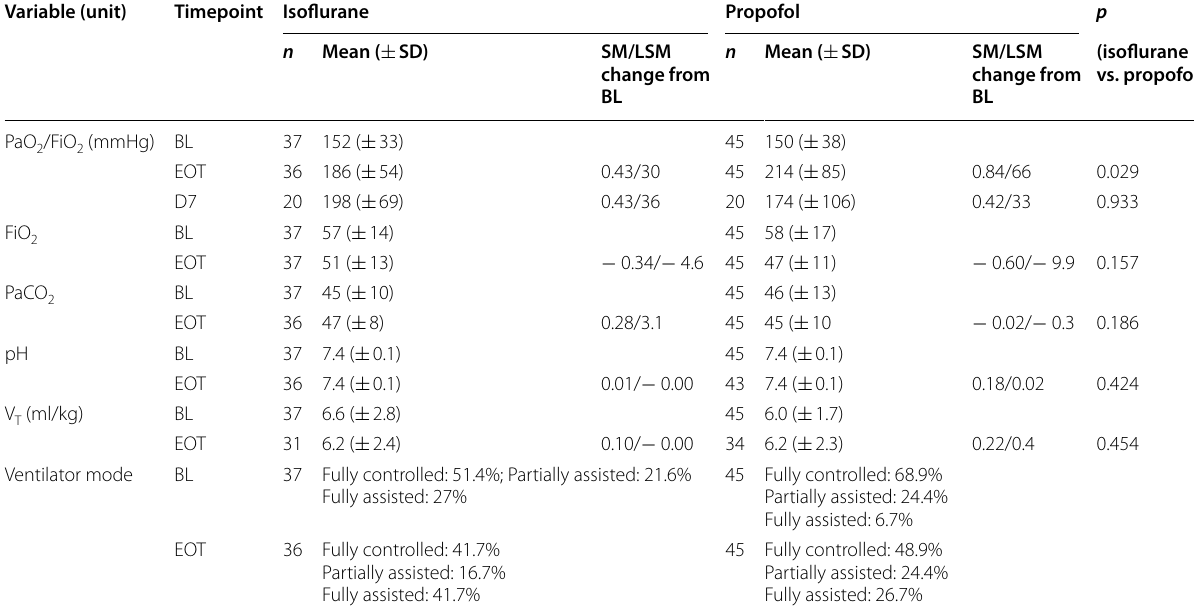
Change in PaO 2 /FiO 2 ratio between baseline (BL) and end of study sedation (EOT, usually after 48 h) LSM least squares mean, SD standard deviation, PaO 2 arterial partial pressure of oxygen, FiO 2 inspired fraction of oxygen, D7 day seven after randomization, SM standardized means mean divided by total pooled standard deviation, V T tidal